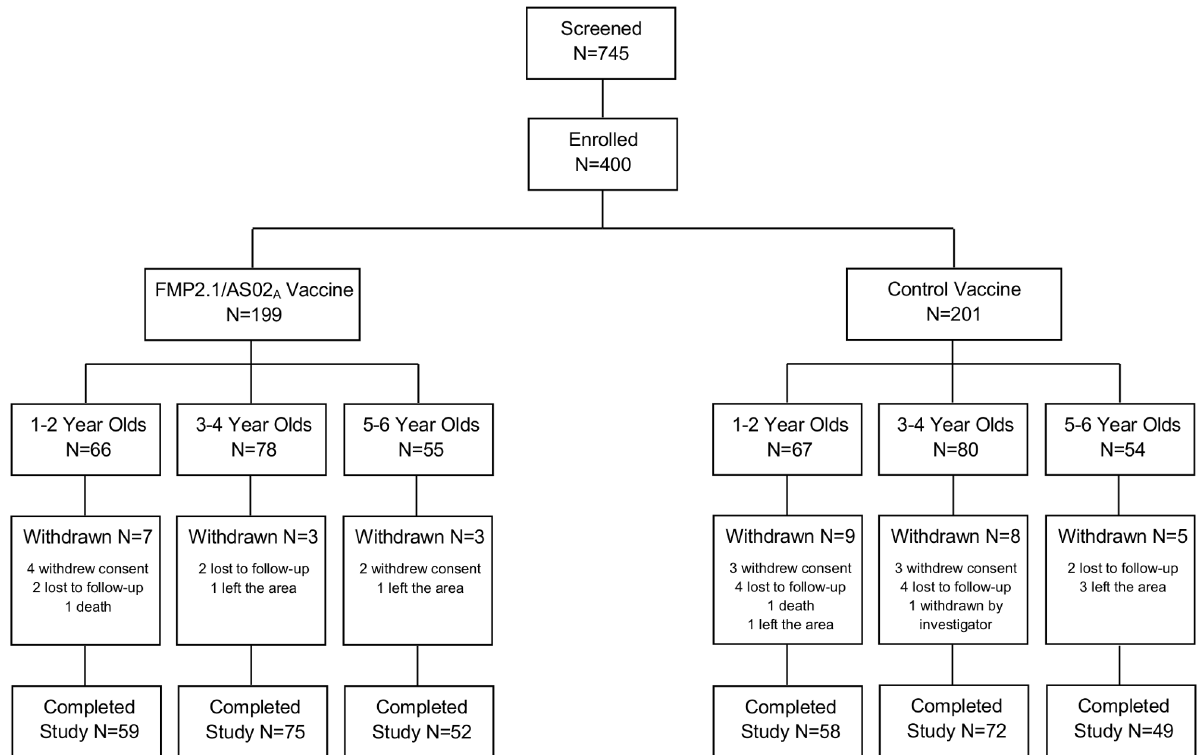
Figure 1. Disposition of study participants.